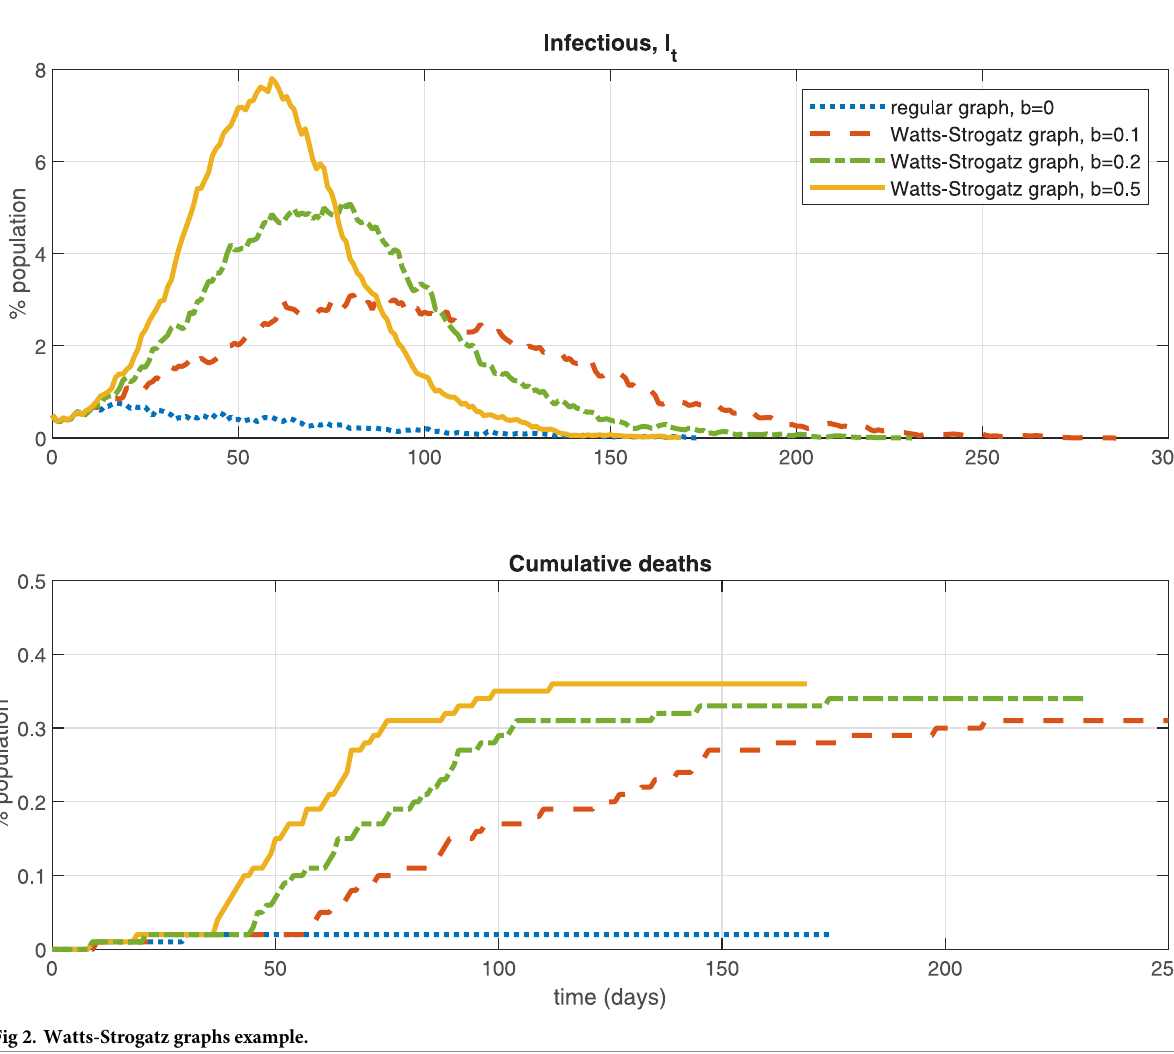
Fig 2. Watts-Strogatz graphs